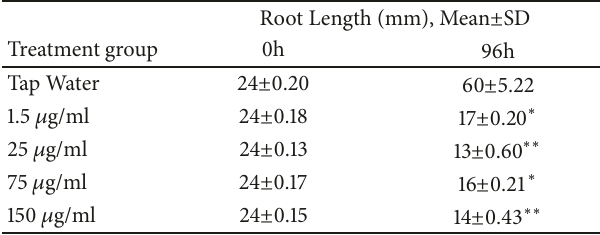
Table1:The96-hourrootgrowthinhibitionteston Alliumcepa